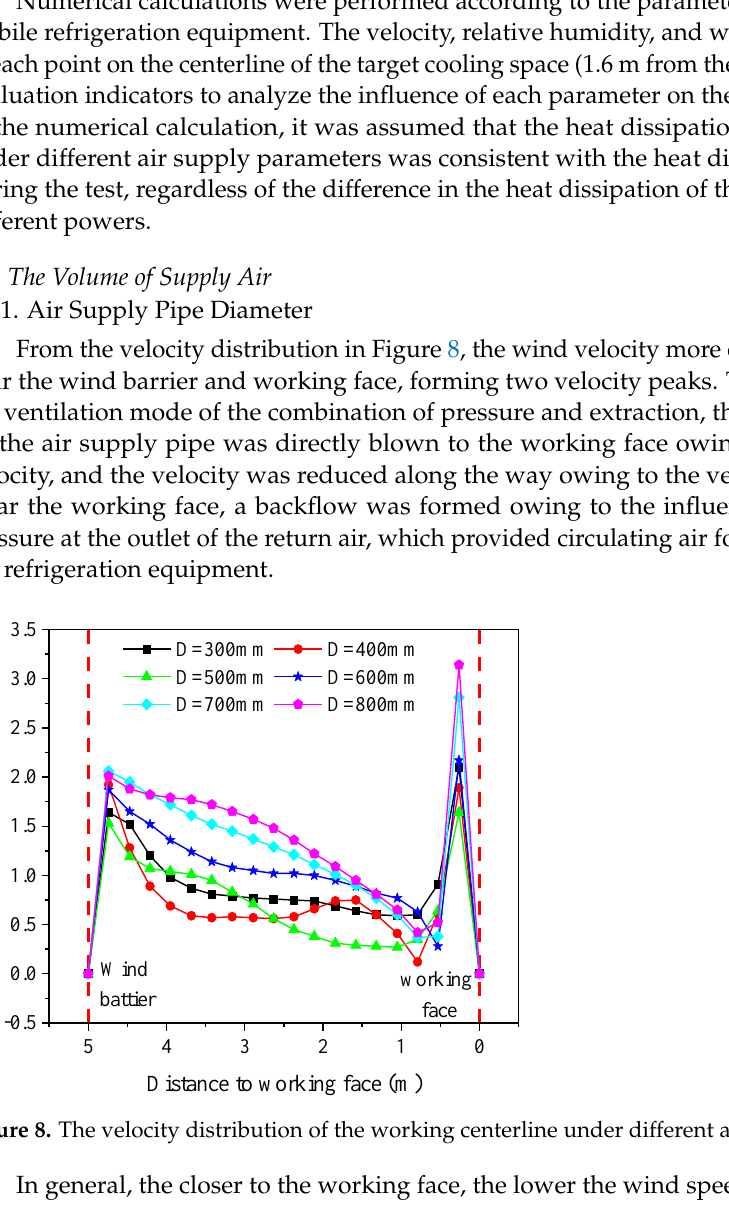
Air supply pipe diameter(mm) MoM drop Cumulative drop Figure 9. Wet bulb temperature distribution of drift centerline under different air supply pipe.